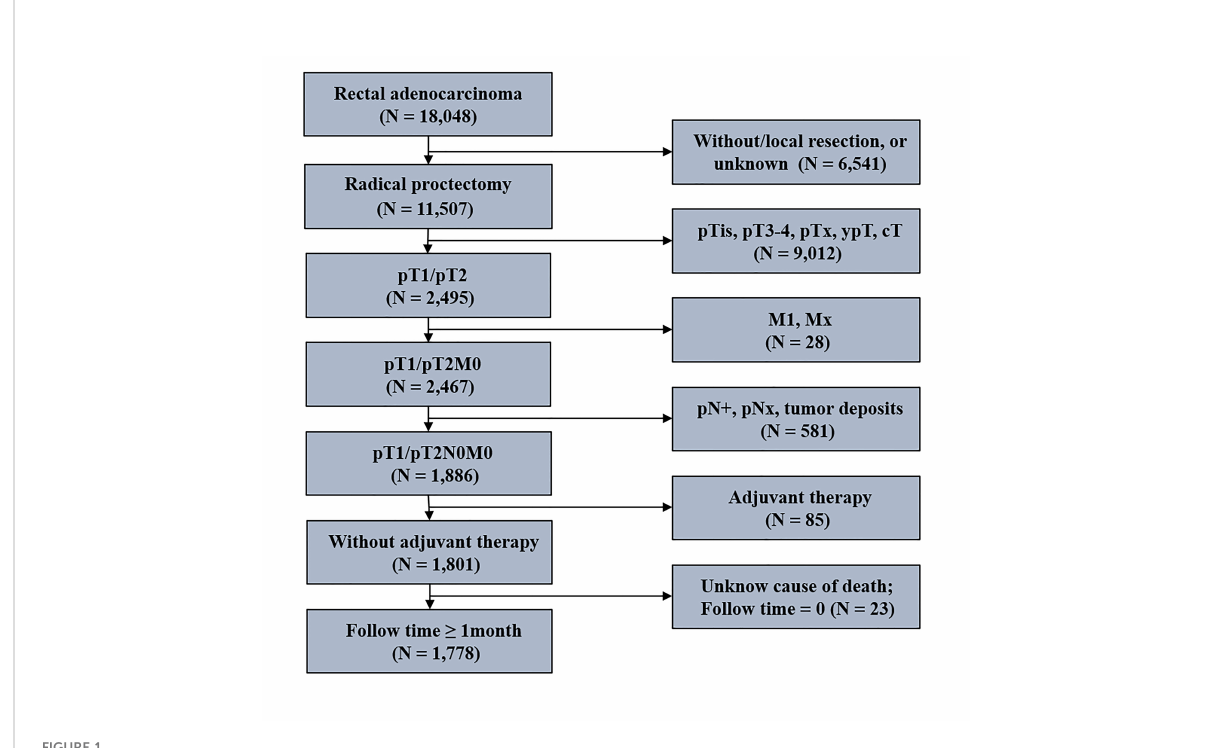
FIGURE 1 The fl owchart of stage I rectal cancer patients included the